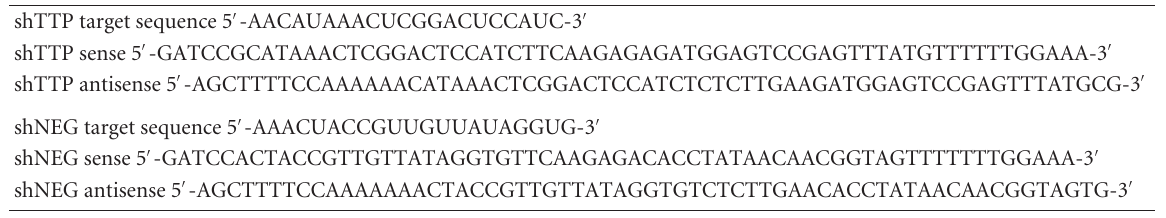
Table 1: Target sequences and primers of shTTP and shNEG.